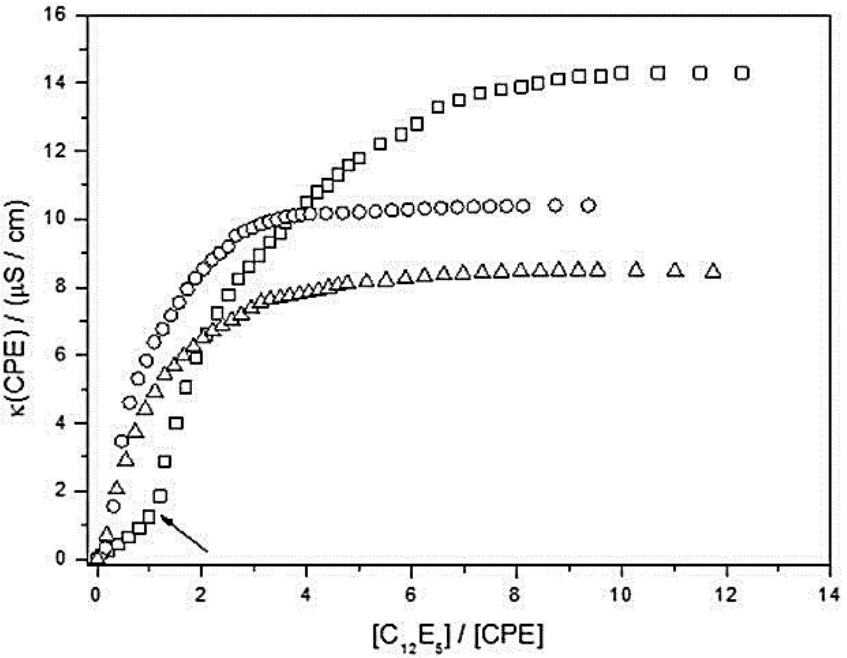
Figure 5. Changes in specific electrical conductance ( κ ) of aqueous solutions of CPEs upon adding C12E5, at 25.0 °C. ( □ ) PBS-PFP, (o) PBS-PFP2, and ( ∆ ) PBS-PFP3. The arrow highlights the cac for PBS-PFP:C 12 E 15 mixed solutions.